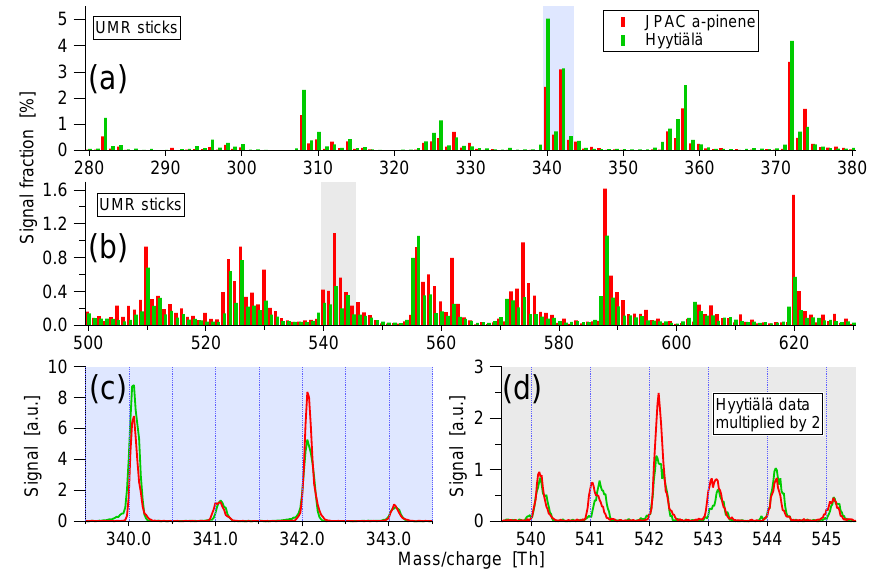
Fig. 2. UMR ( a and b ) and high-resolution ( c and d ) comparison of JPAC a-pinene (red) and Hyyti¨al¨a ambient (green) data. The bars have been offset slightly for an easier comparison. The spectra correspond to Fig. 1c and d, respectively. The blue-shaded region in plot (a) corresponds to (c) , and the grey-shaded region in (b) corresponds to (d)